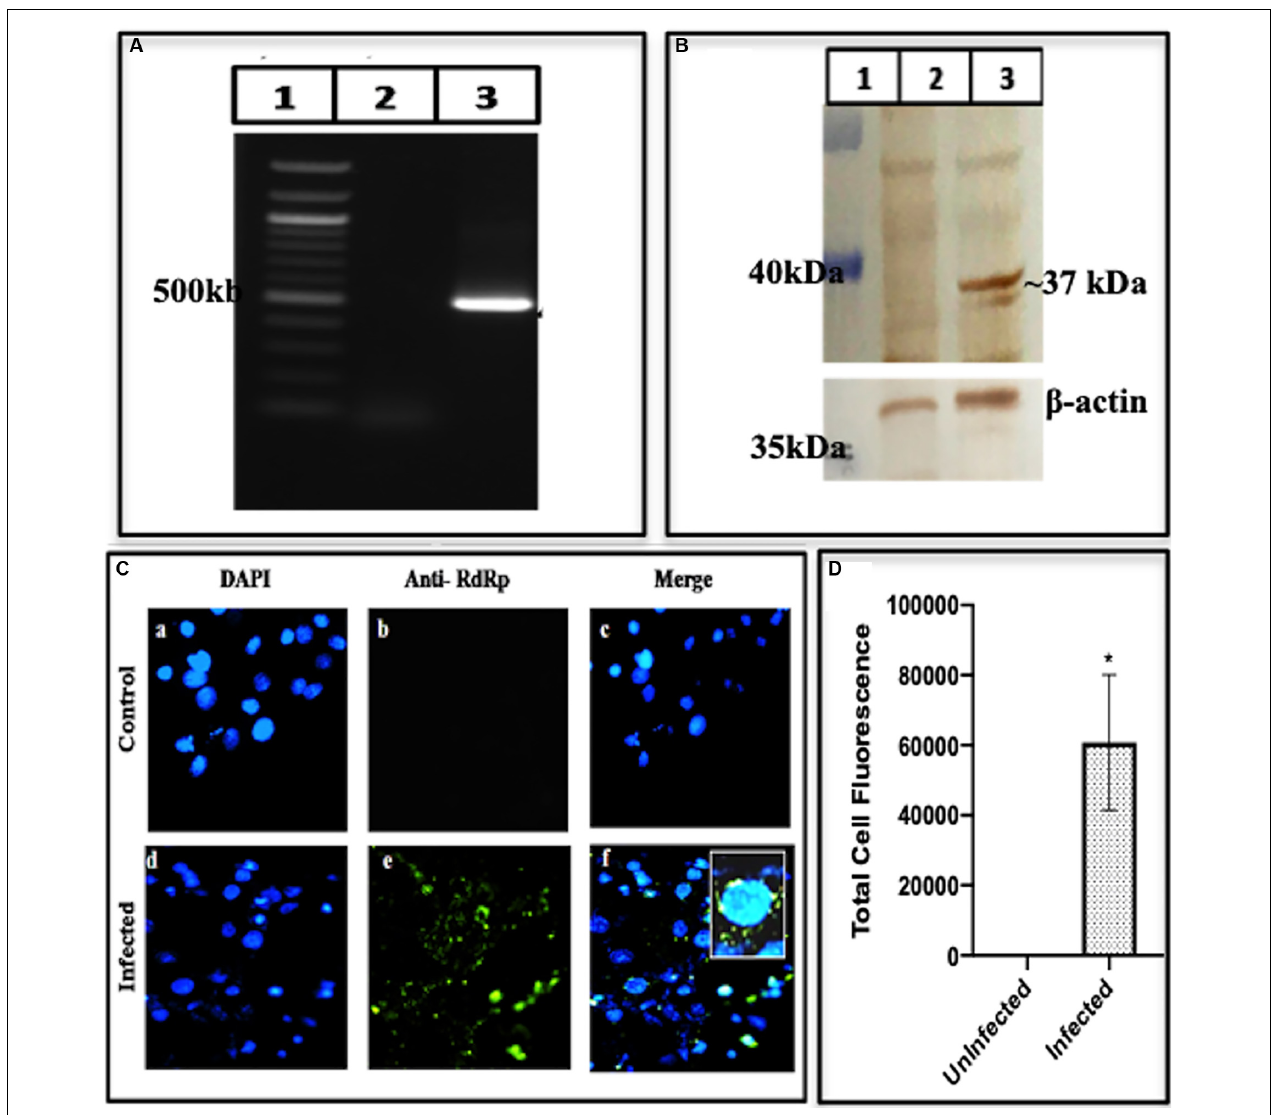
FIGURE 6 | Expression of RNA-dependent RNA polymerase. (A) PCR amplification of RdRp from BacMam-HEV infected cells using RdRp specific primers ( Supplementary Table S1 ). The corresponding lanes are as follows: marker (lane 1), cDNA from uninfected cells (lane 2), cDNA from infected cells (lane 3). (B) Western blot analysis using anti-RdRp Antibody and Goat Anti-Rabbit IgG HRP conjugated secondary antibody. The corresponding lanes are as follows: marker (lane 1), cell lysate from Huh7 control cells (lane 2), cell lysate from infected Huh7 cells showing specific band identical to the size of HEV RNA dependent RNA polymerase (lane 3). (C) Immunofluorescence assay: cells were stained with Anti-RdRp Primary Antibody detected with Alexa Fluor 488 Goat Anti-Rabbit IgG secondary antibody and counterstained with DAPI to stain nuclei. Panels (a–c) represent control Huh cells and panels (d–f) represent HEV infected cells. Panels (c,f) represent the merged image of (a,b) and (d,f) , respectively. (D) The graph represents the mean fluorescence intensity, and the error bar indicates the standard deviation. The data was significantly tested using Mann–Whitney test ( p -value = 0.0286). * indicates p -value < 0.05. All experiments were performed at least three times as independent